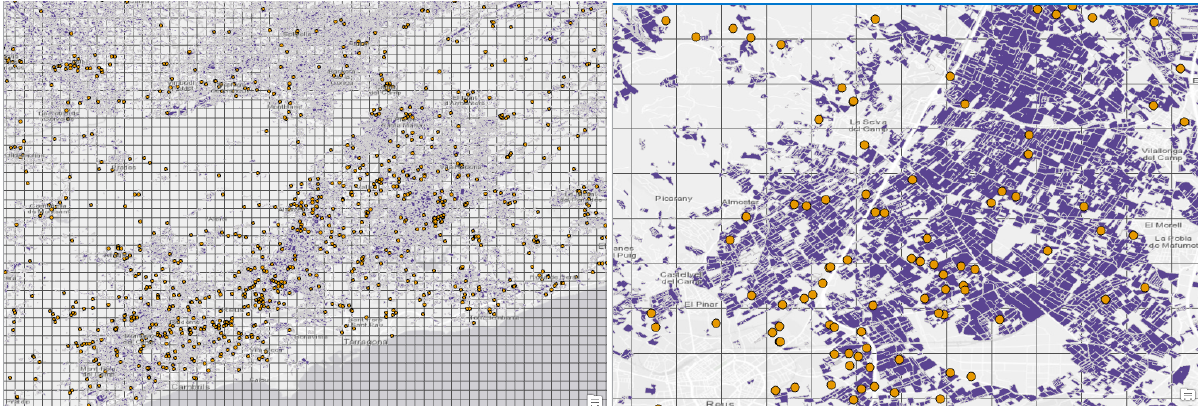
Figure 2. Division of the area of Catalonia in cells of 1 square kilometre each (left). Example grid cells in a dense agricultural area of the region (right). This is a zoom of the map on the left. Livestock farms are shown in brown, crop fields in